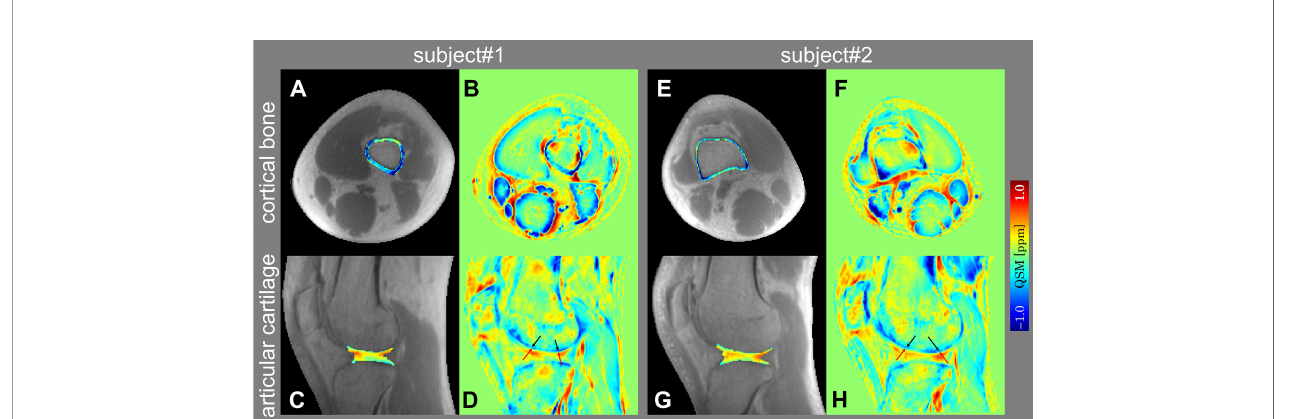
FIGURE 2 | Representative slices of UTE-QSM in cortical bone (A, E) and articular cartilage (C, G) overlaid on the UTE magnitude images in axial and sagittal views of two subjects. (B, F) and (D, H) are the color-coded magnetic susceptibility maps within the whole FOV corresponding to (A, E) and (C, G) . The black and red arrows in (D, H) point to the subchondral bone and deep layer of articular